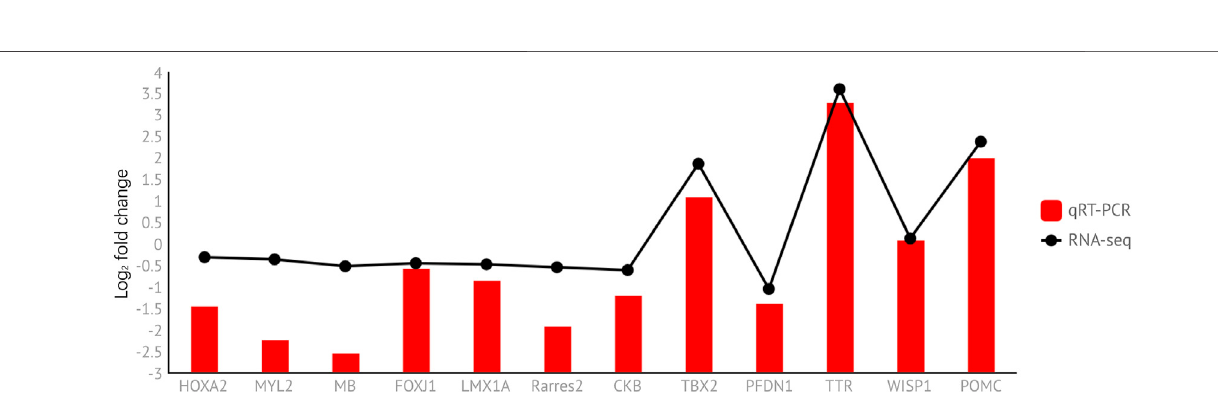
Frontiers in Genetics |